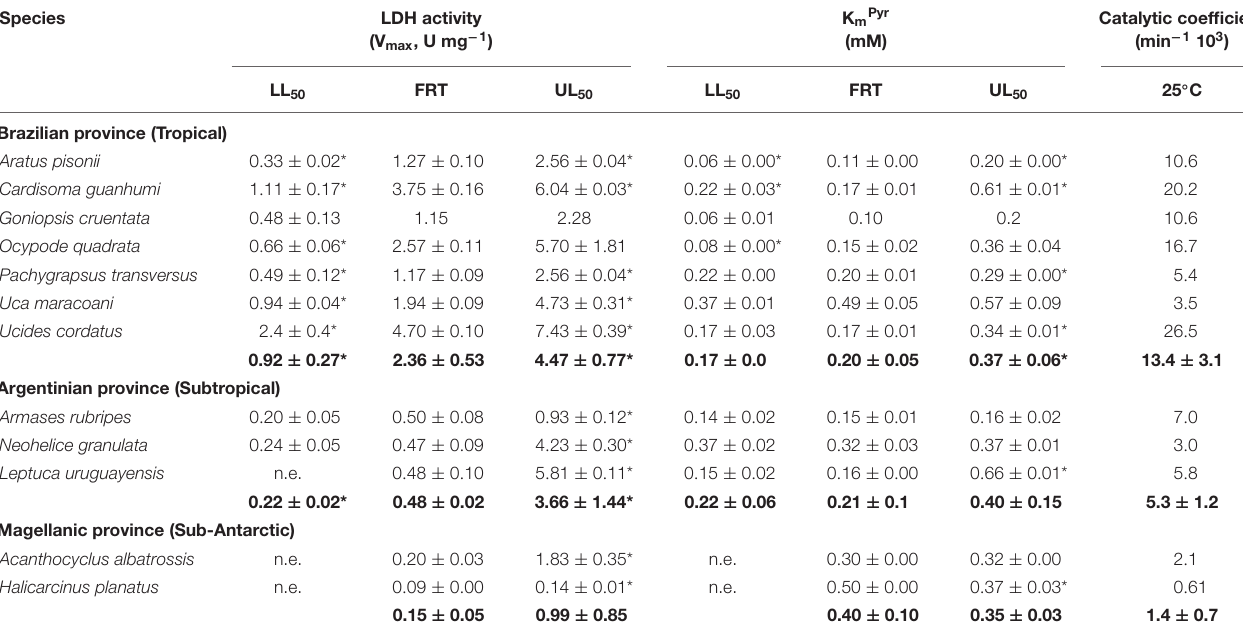
TABLE 3 | Crab species and their kinetic parameters, LDH activity (V max , U mg − 1 ) and K mPyr (mM), measured at their respective field reference temperatures (FRT) and lower (LL 50 ) and upper (UL 50 ) critical thermal